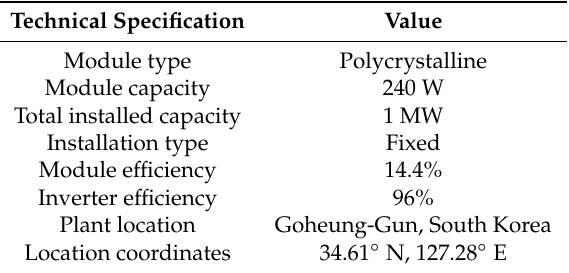
Table 2. Technical specifications of the photovoltaic (PV)